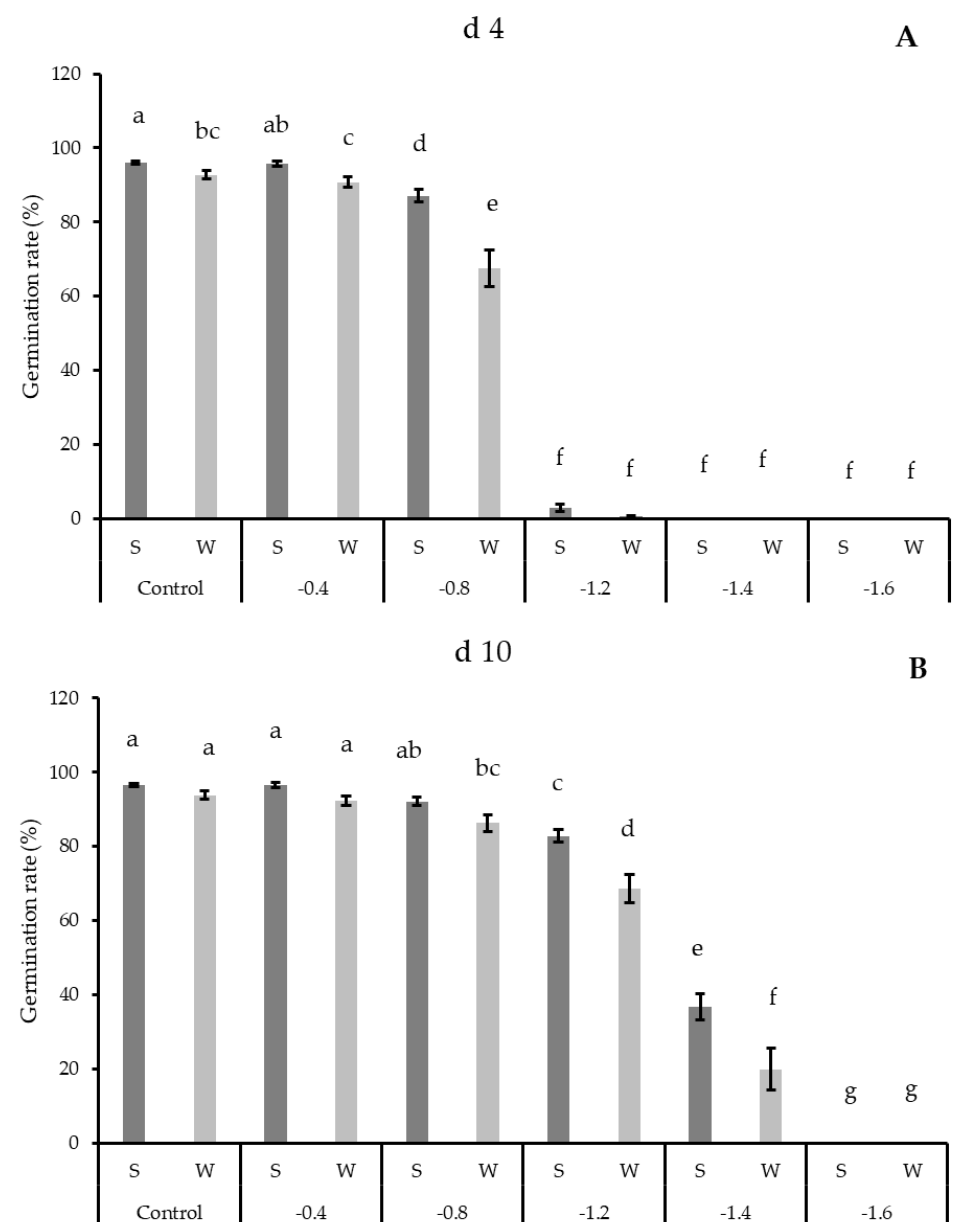
Figure 1. Camelina germination percentage (%), surveyed at 4 ( A ) and 10 days ( B ) after stress imposition, as a ff ected by the interaction of osmotic stress level (Control = 0, − 0.4, − 0.8, − 1.2, − 1.4, − 1.6 MPa) × biotype (winter, spring). Mean values ± SE. Di ff erent letters: statistically di ff erent means for p ≤ 0.05 (LSD’s test).